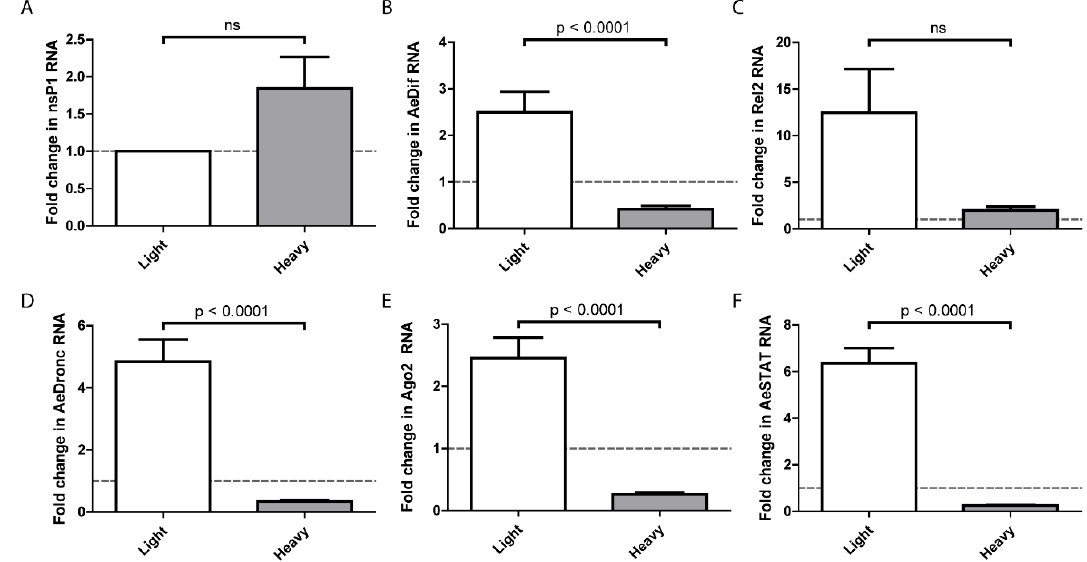
Figure 5. Midgut immune response. Infected midguts were dissected out at 1 DPF and homogenized. RNA was extracted with TRIzol and cDNA was synthesized to quantify RNA levels of ( A ) nsP1 and indicator genes for Toll ( B ), IMD ( C ), JAK-STAT ( D ), apoptosis ( E ), and RNAi ( F ) pathways. P values were calculated by Mann–Whitney test. All error bars represent standard error of mean (SEM). The dashed line indicates gene expression levels in mosquitoes following a noninfectious blood meal.